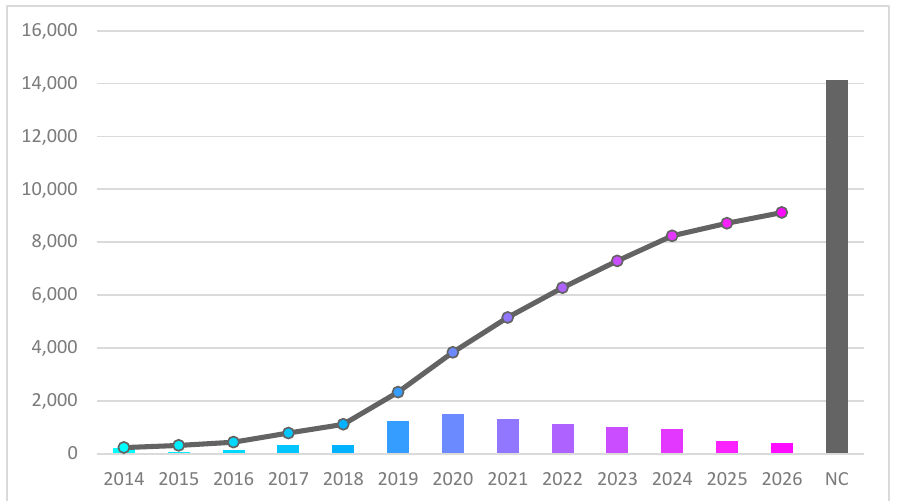
Figure 2. Expected time evolution of in orbit spacecraft due to constellations. Colored histogram bars represent the estimated number of satellites launched yearly (see Table A1 in Appendix A for details). Black, dotted line represents cumulative sum. Not-classified (NC) stands for companies that have not published expected